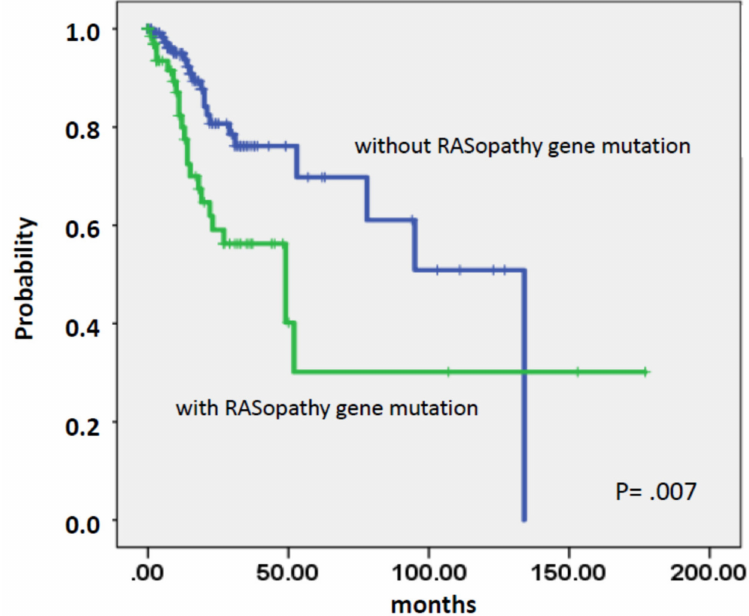
Figure 2. Time to AML transformation in chronic myelomonocytic leukemia (CMML) patients stratified by the presence or absence of RASopathy gene